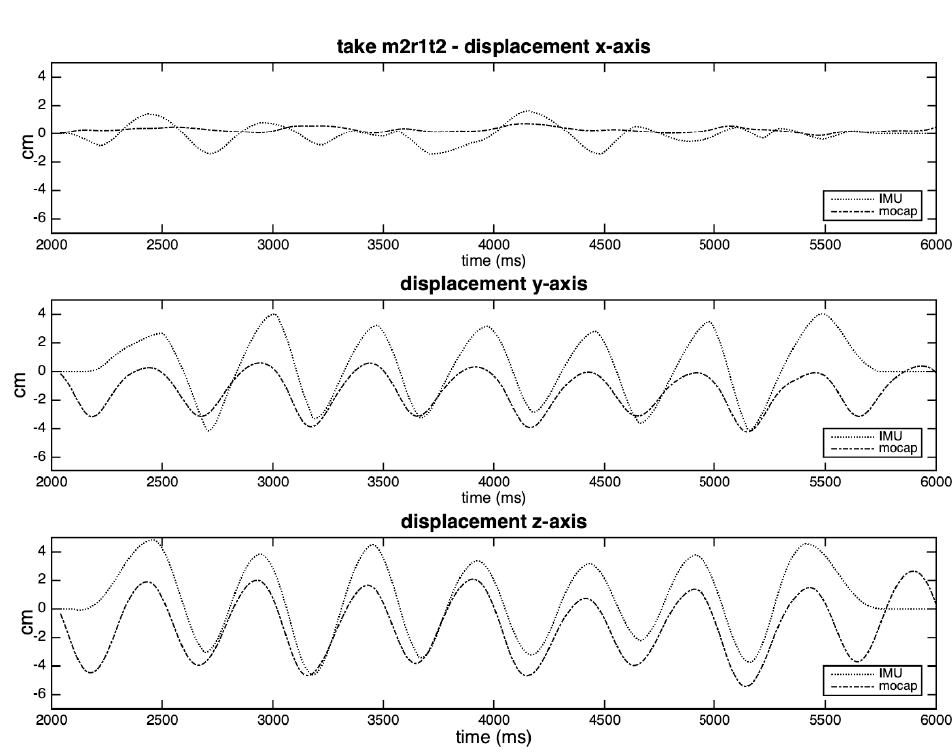
Figure 16. Displacement curves estimated for each axis of take m2r1t2, balanced according to the stronger